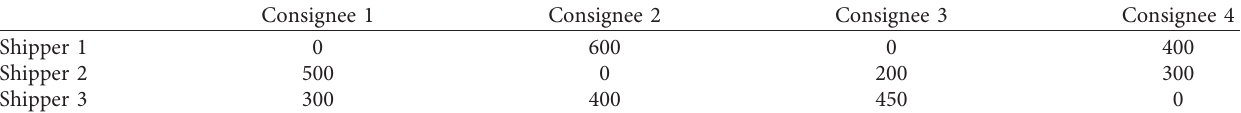
Table 7: Circulation of cargoes at supply and demand points in the medium bulk cargo transport network.